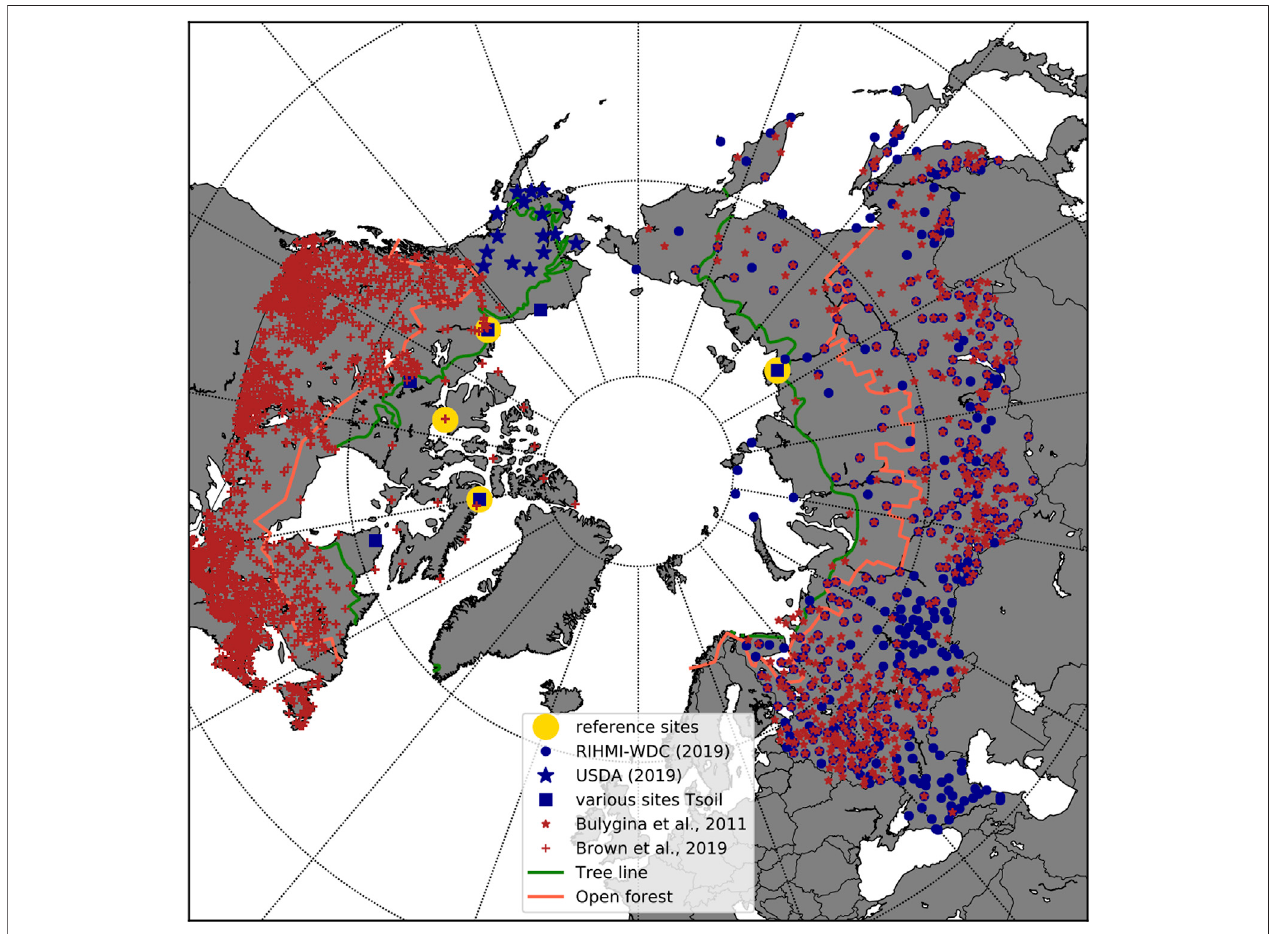
FIGURE 1 | In-situ data map of soil temperature observations from different sources (blue), snowpack observations (red) and reference sites used to evaluate the simulations (yellow). The reference sites (yellow points) are described in Tables 1 , 2 , and networks of blue points in Table 2 .